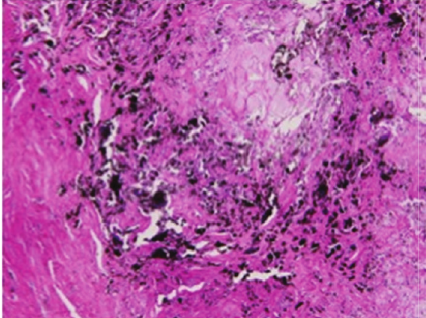
Figure4:HEstainofthespecimenrevealeddegenerativetissuewith calcification and granulomas associated with histiocytes laden with fragments of black graphite (Hematoxylin eosin stain, ×